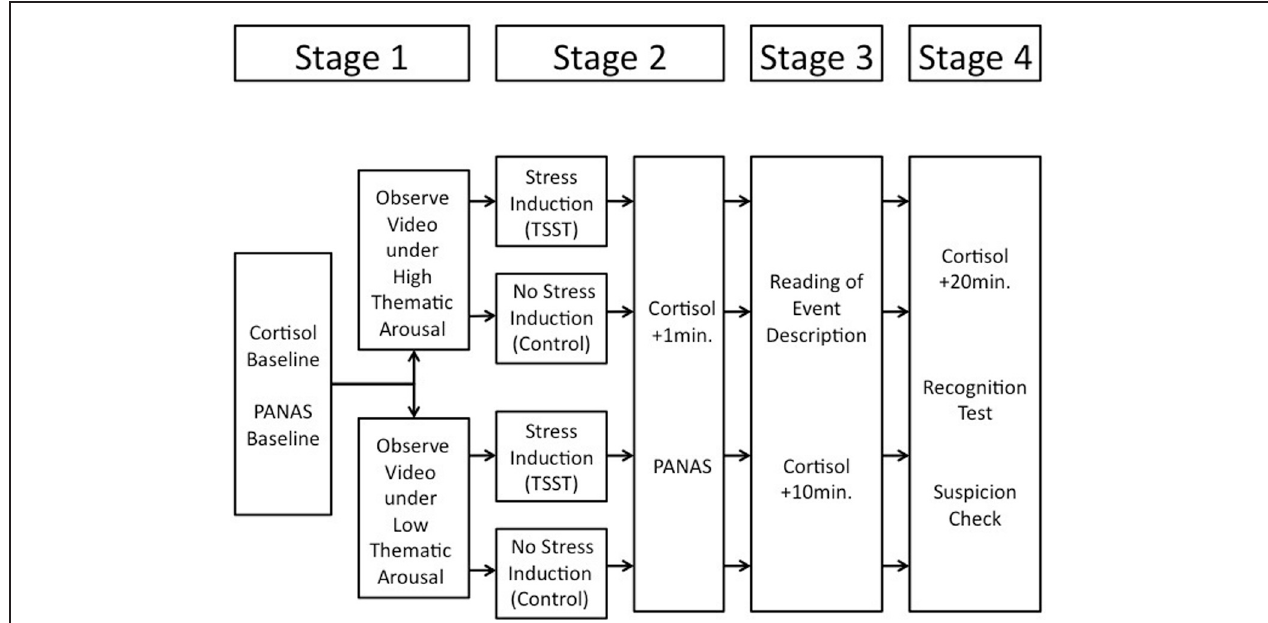
FIGURE 1 | Overview of the procedure; the duration of the video was ∼ 12min, the duration of the TSST was ∼ 15min.